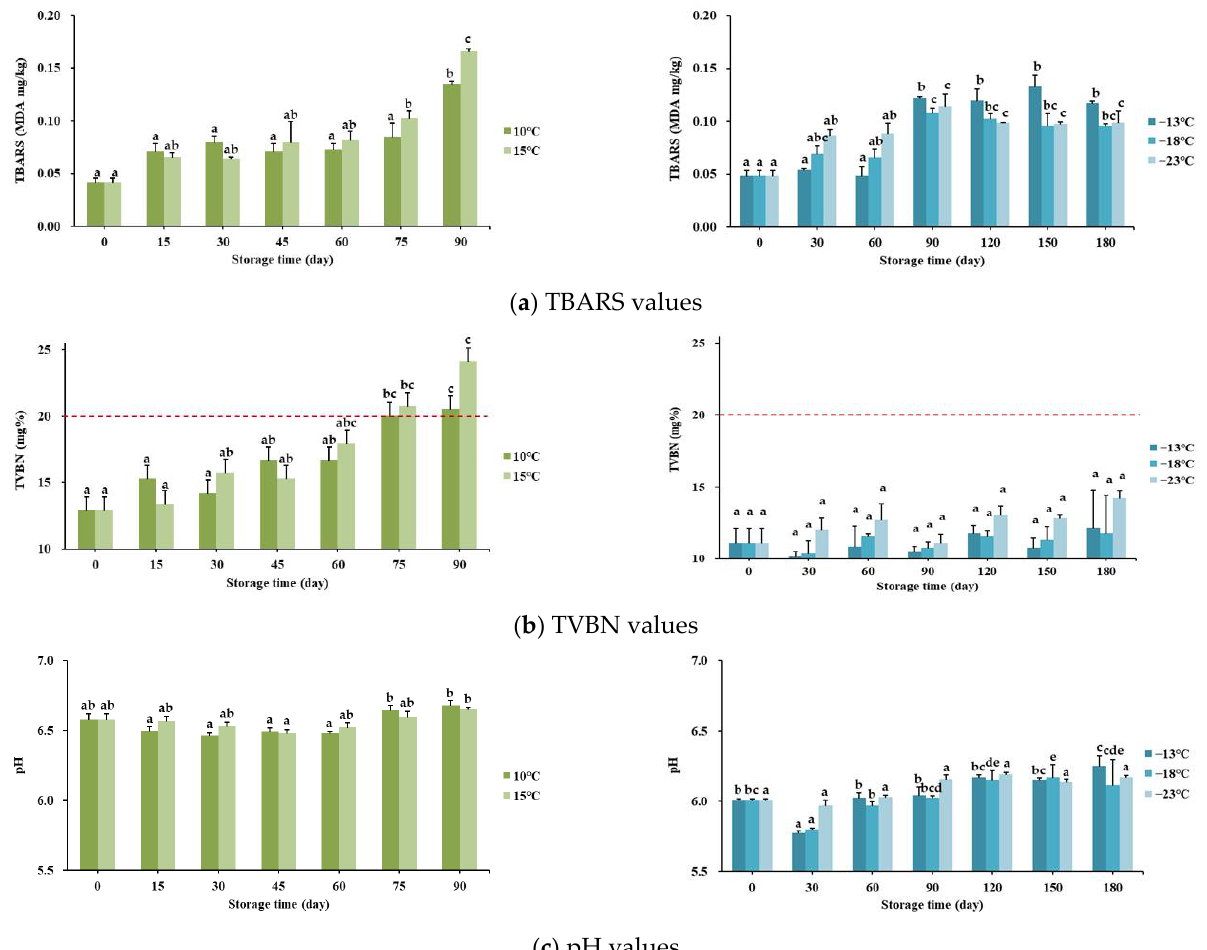
Figure 6. Periodical values in the chemical properties (TBARS, TVBN, pH) of processed chicken products stored at different temperatures for storage days (90 and 180). Values are mean ± SE. Different letters (a–c) indicate significant differences among means by Tukey’s test ( p < 0.05); ■■ values for chicken leg, ■■■ values for chicken breast.